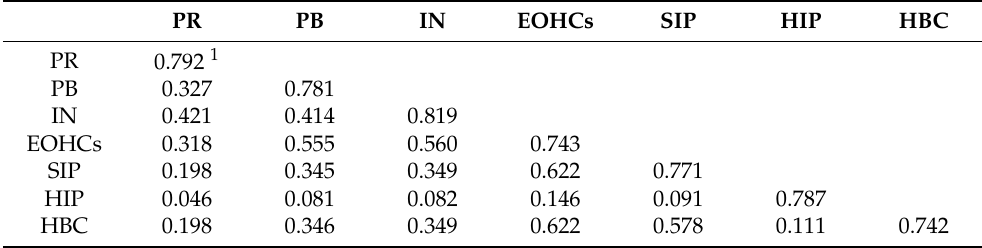
Table 4. Correlation matrix (N =